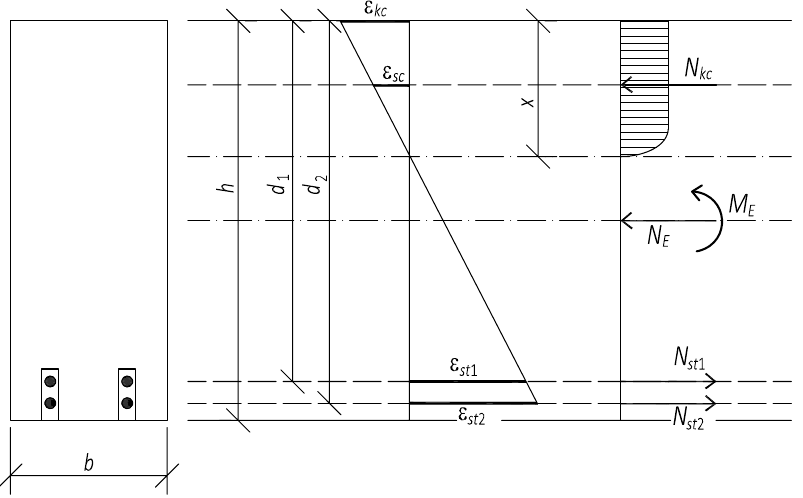
Figure 11. Assumptions of the limit strain